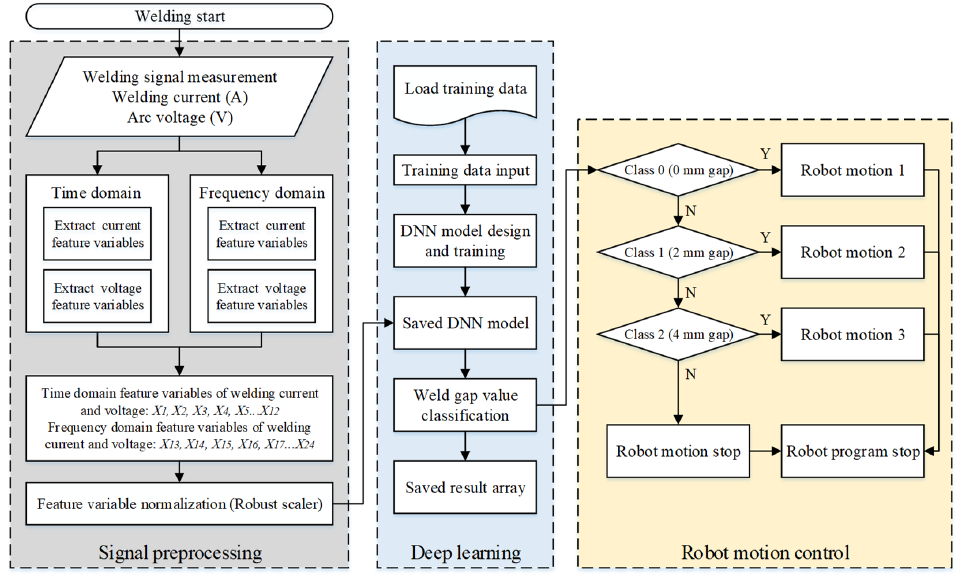
Figure 13. Flowchart of the technical roadmap.